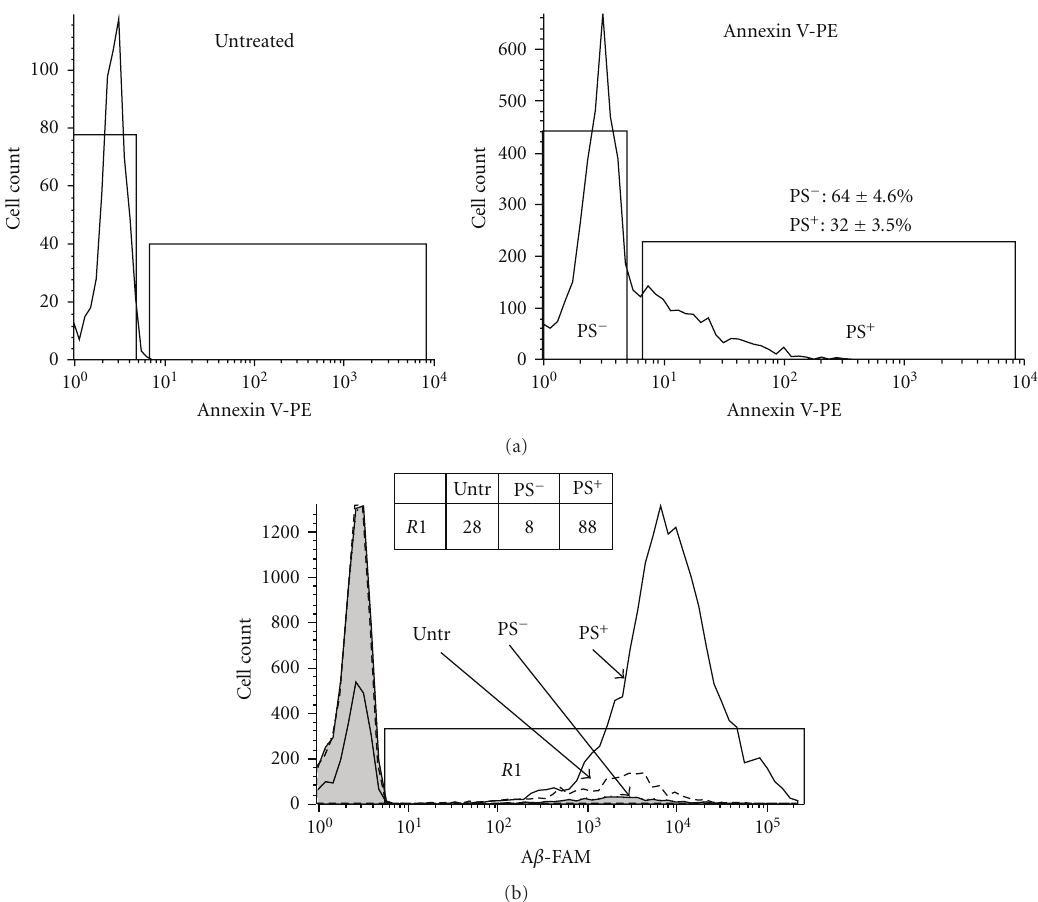
Figure 3: Correlation between A β -FAM binding and surface PtdSer observed on cells sorted on the basis of annexin V-PE binding. PC12 cells were exposed to annexin V-PE for 20min, and sorted based on the levels of annexin V-PE binding. The histograms in (a) show the results of the distribution of the cells. The numbers in the figures are the averaged percentage of PtdSer − and PtdSer + cells from four sorting experiments. The resulting groups of cells, untreated control, PtdSer + , and PtdSer − were then treated with A β -FAM. (b) shows the fluorescence histograms on the basis of A β -FAM binding. The results of cell count in the R 1 gate, A β -FAM positive cells, show that the PtdSer + group of cells has the highest percentage (88%) of cells with bound A β